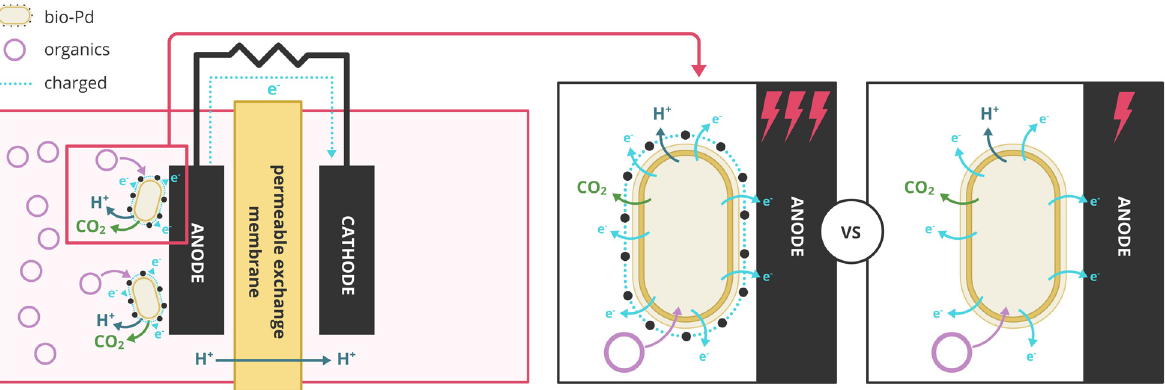
Figure 3: Coating anode with bio - Pd in the MFC system to increase the generation of energy. The fi gure was adapted from Hou et al. [ 24 ]